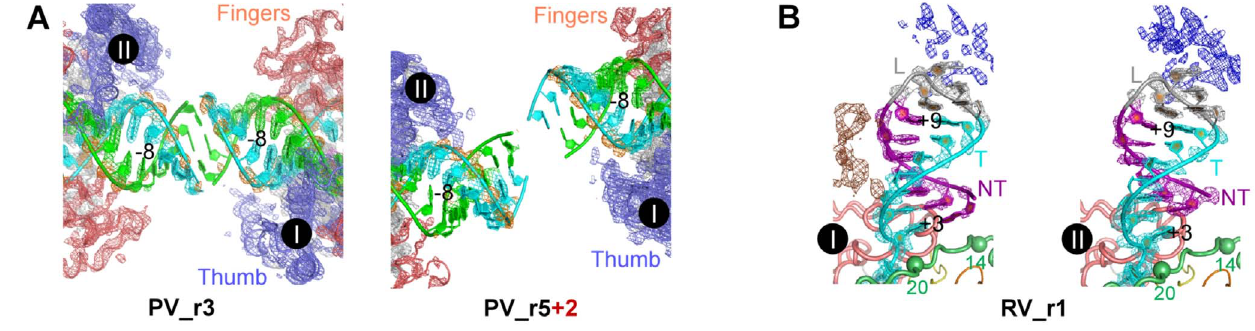
Figure 2. Electron density at RNA-mediated inter-complex crystal contacts. A) 3500 K composite simulated-annealing (SA) omit electron density maps (contoured at 1.5 s ) of the RNA-RNA junctions responsible for forming the dumbbell EC pairs. The left image is of the straightest junction (PV_r3) and the right image is of the most distorted junction (PV_r5 + 2). Note that despite the distortion and weak density around the junctions themselves, the upstream duplex largely maintains its A-form conformation as it exits the polymerase between the thumb and fingers domains. RNA strands and the associated density are color coded as in Figure 1 with phosphate density highlighted in orange. Polymerase molecules are shown in a three-color scheme with thumb, fingers, and palm domains in blue, red, and grey, respectively. B) Crystal packing contacts stabilizing the orientation of the downstream RNA stem-loop in the two different RV_r1 ECs. The 3500 K SA-omit electron density maps (1.5 s ) show electron density from two additional polymerase molecules (brown and blue) that make non-specific interactions with the tetra-loop and the downstream duplex. The RNA is colored as in Figure 1, the polymerase index (green) and pinky (pink) finger regions that form the cleft on which the downstream RNA duplex rides are shown as thick noodles, and the a -carbon atoms of the index finger residues 14 and 20 are shown for orientation.